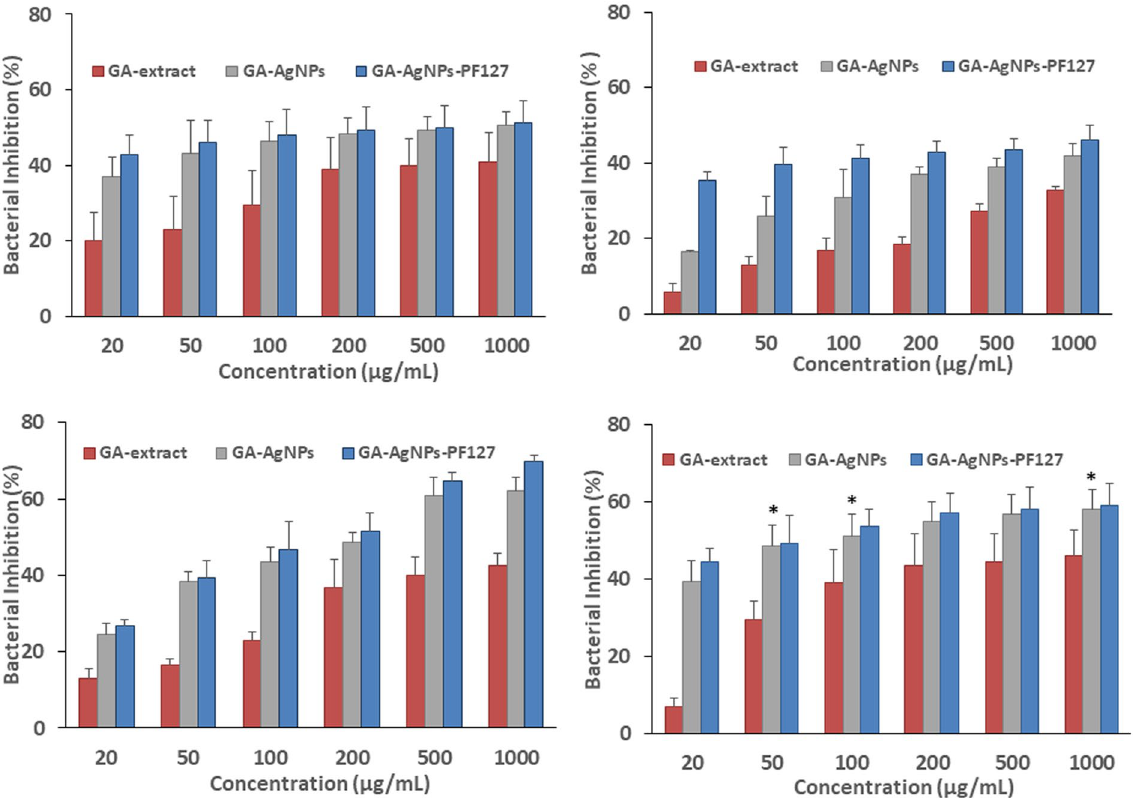
Figure 5. Biofilm inhibition effect of GA-extract, GA-AgNPs, and GA-AgNPs-PF127 on ( A ) B. cereus , ( B ) E. coli , ( C ) P. aeruginosa , and ( D ) S. aureus. Data represent mean value ± standard deviation. *p < 0.01.